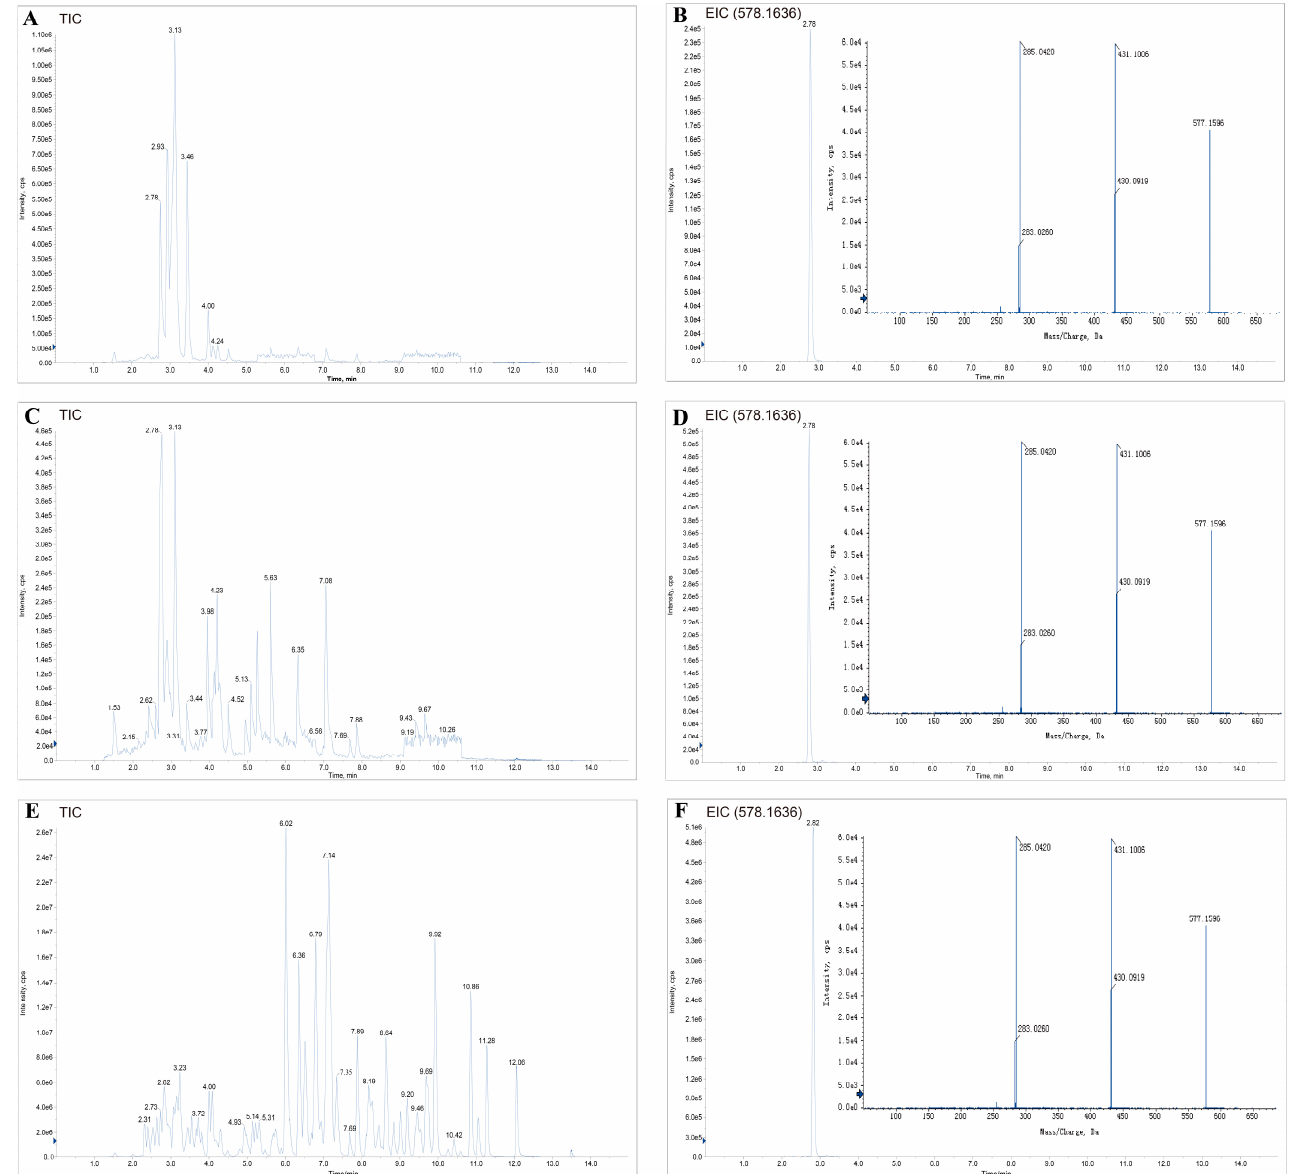
Figure 3. The typical chromatograms of the extracts from the positive/negative mode analyzed by LC-MS/MS: ( A ) Total ion current chromatogram (TIC) of C. oleifera nectar. ( B ) Extracted ion chromatogram (EIC) and mass spectrum of kaempferitrin in C. oleifera nectar. ( C ) TIC of C. oleifera honey. ( D ) EIC and mass spectrum of kaempferitrin in C. oleifera honey. ( E ) TIC of kaempferitrin standard. ( F ) EIC and mass spectrum of kaempferitrin